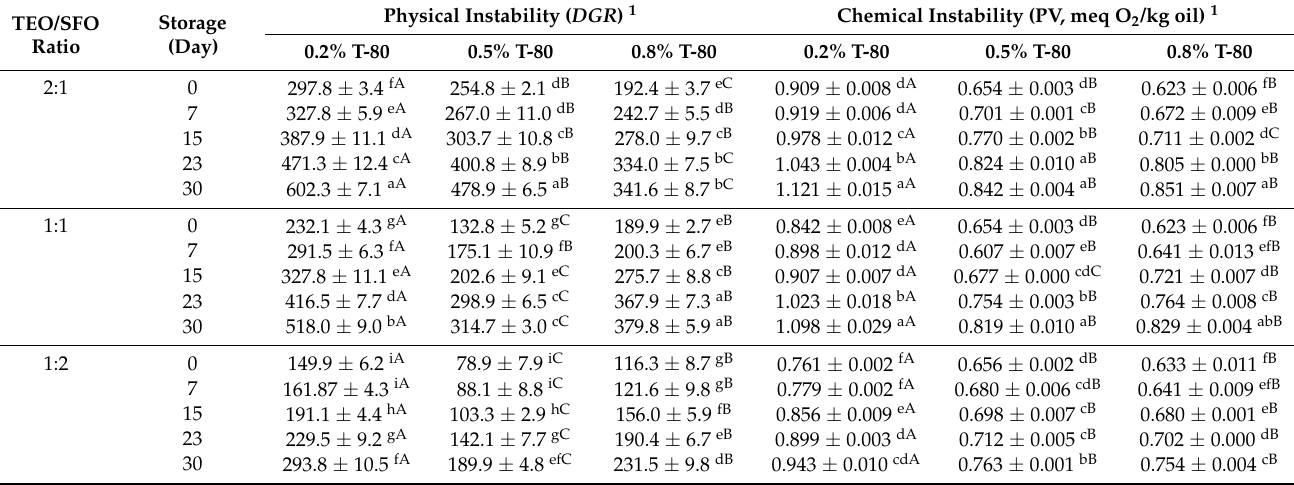
Table 2. Storage-dependent droplet growth ratio ( DGR ) and peroxide value (PV) changes of TEO-NEs at different TEO/SFO ratios and tween-80 (T-80) levels for 30 days at room